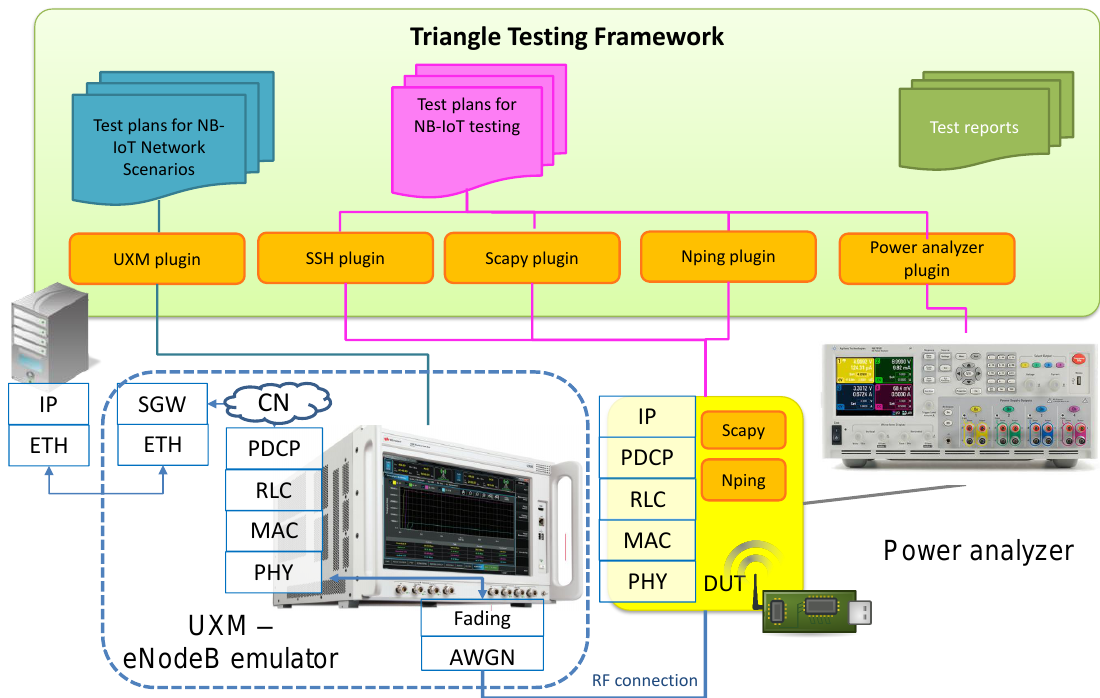
Figure 6. Testing environment for NB-IoT solutions.